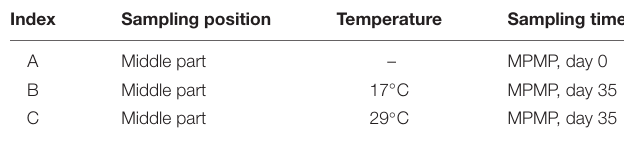
TABLE 1 | The information for mycelia